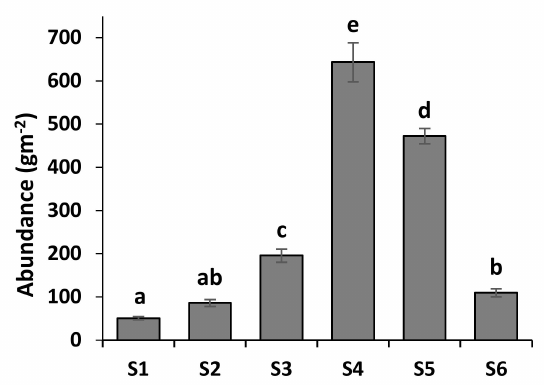
Figure 3. Total macroplastics concentrations in different study areas. Different letters exhibit signifi- cant differences ( p <